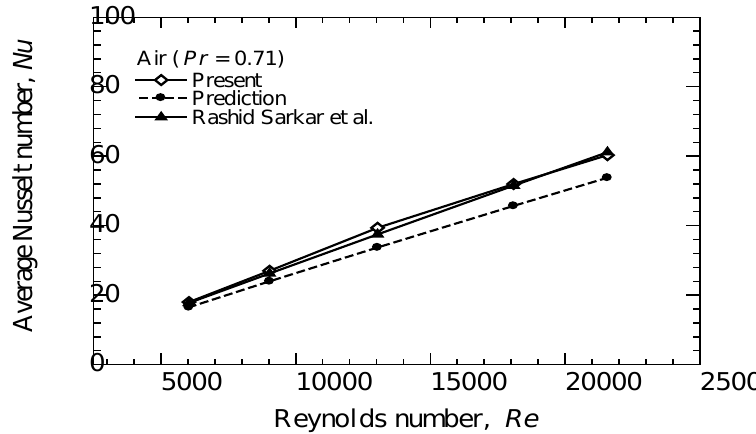
Figure 12: Prediction of heat transfer coefficients for smooth